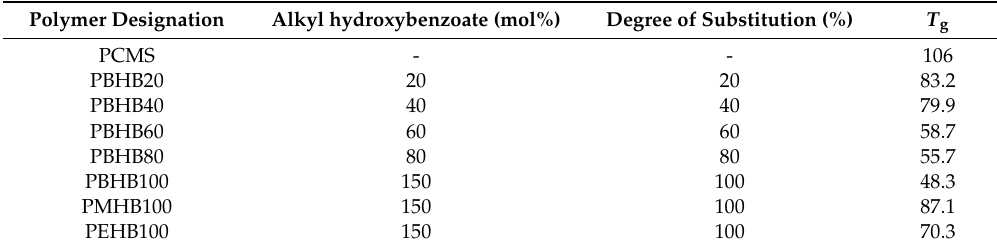
Figure 2. DSC (Differential scanning calorimetry) thermogram of PBHB# (PBHB20, PBHB40, PBHB60, PBHB80, and PBHB100) and PMHB100 and PEHB100. Table 1. Reaction conditions and results for the synthesis of the PCMS and PBHB# and PMHB100 and PEHB100.